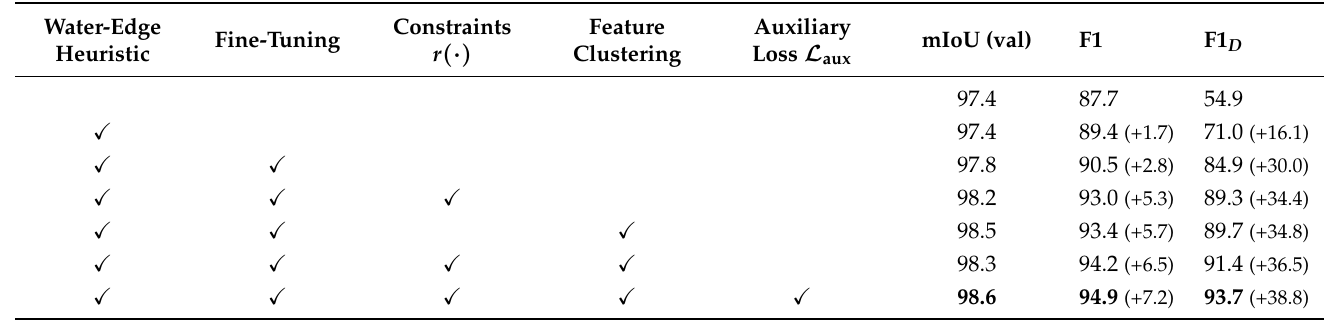
Table 5. Ablation study on MODS (detection F1/F1 D ) and MaSTr1325 validation set segmentation (mIoU). Enabling: water–edge static-obstacle heuristic (Equation (2)), model fine-tuning (Section 3.3), applying constraints r ( · ) during fine-tuning (Section 3.2), feature clustering for re-estimating pseudo labels (Section 3.2) and the auxiliary warm-up loss L aux (Section 3.1.2). Best results for each metric are denoted in bold.